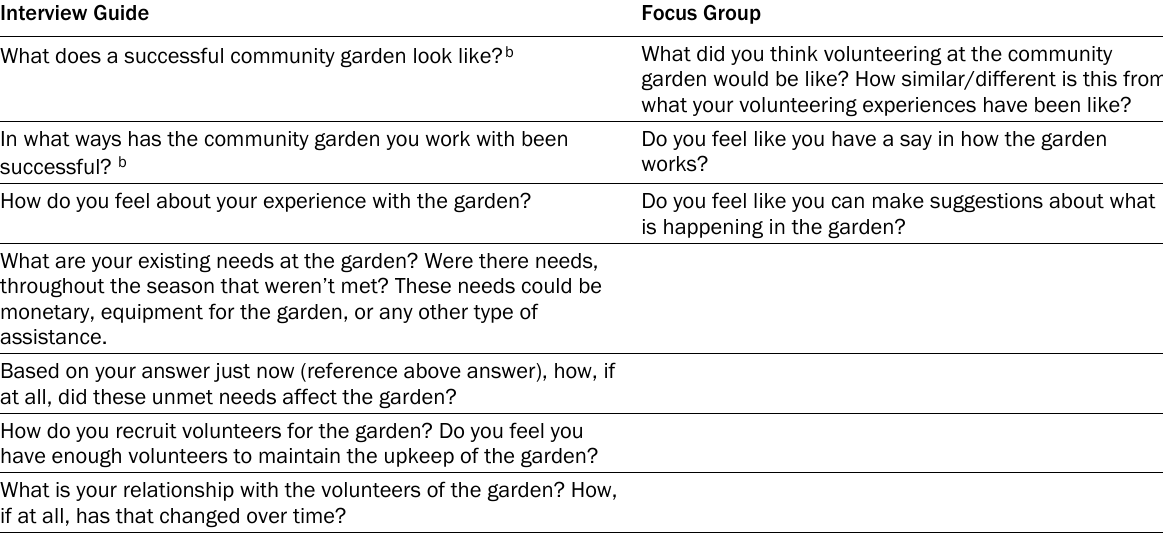
Table 2. Key Interview and Focus Group Guide Questions